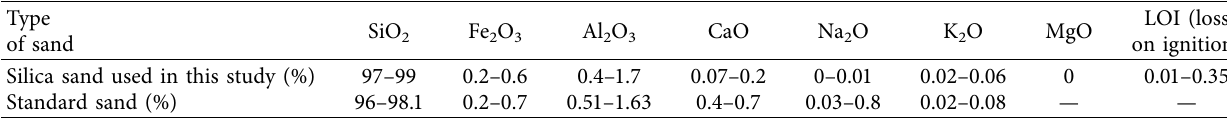
Table 5: Chemical analysis of silica sand and comparing it with standard